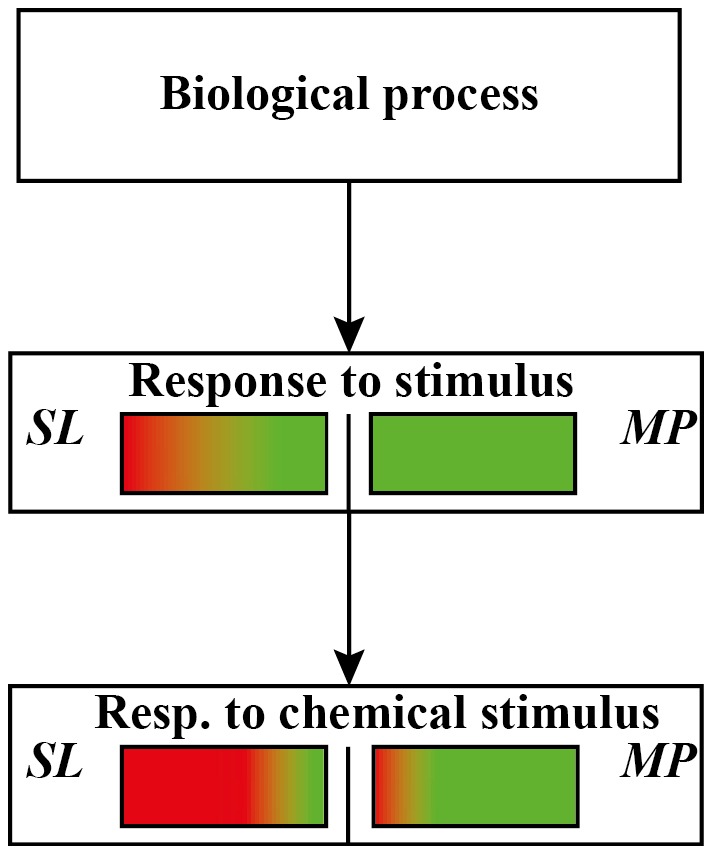
GO analysis of Arabidopsis commonly expressed genes upon Spodoptera littoralis (SL) and Myzus persicae (MP) herbivory.Red color indicates up-regulation, green color indicates down-regulation.